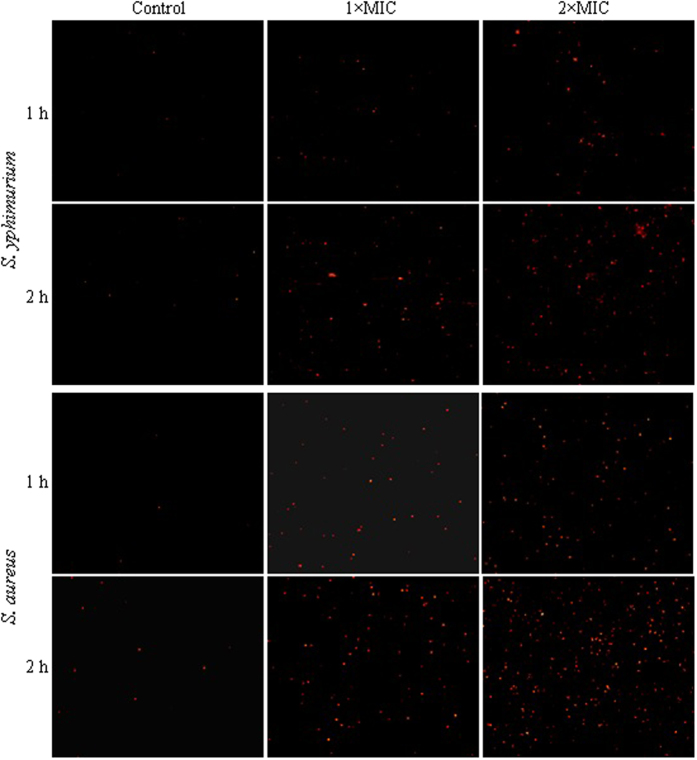
Fluorescence microscopy images of S. yphimurium and S. aureus treated with essential oil of different concentrations for 1 h and 2 h, respectively.